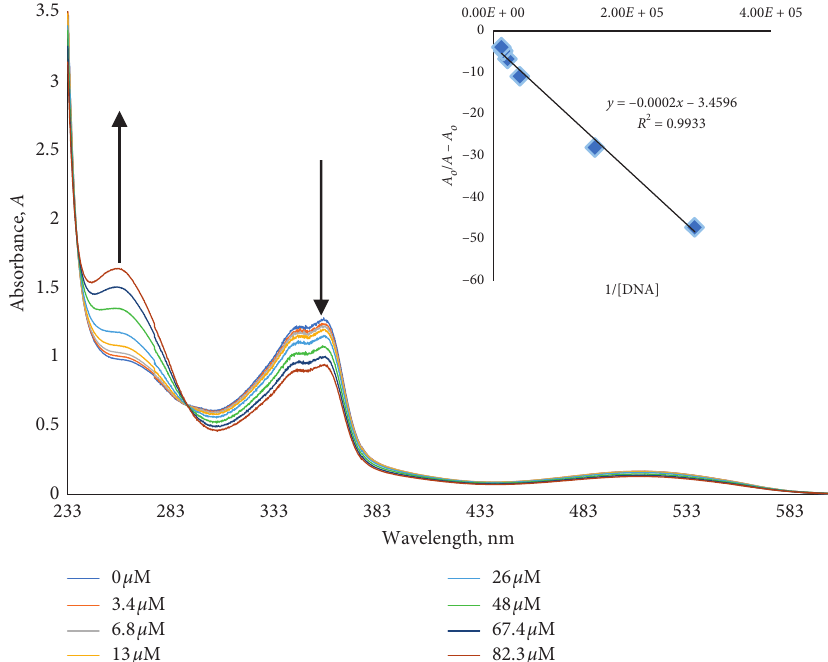
Figure 12: UV-visible absorption spectra for the C3 at 18 µ M without CT-DNA and with serial addition of DNA. Inset is the Bene- si–Hildebrand plots for the determination of binding